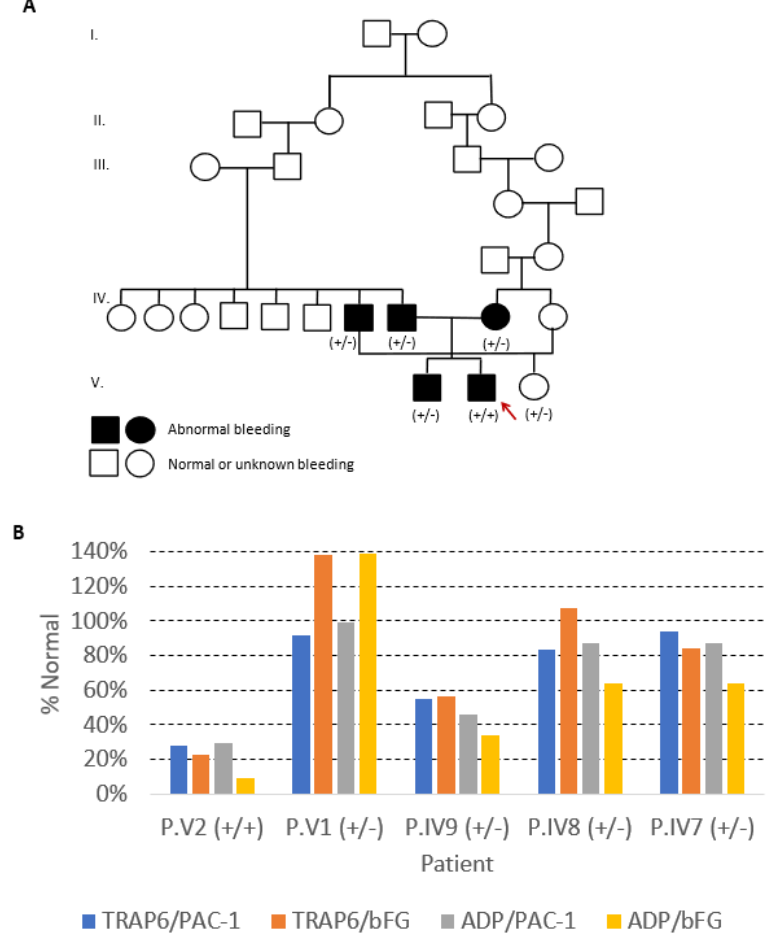
Figure 1. ( A ) Family pedigree of the index case (V2) with a homozygous likely pathogenic variant in RASGRP2 . The black symbols indicate cases with abnormal bleeding and the white symbols indicate family members without or unknown bleeding symptoms. The index case is signaled with an arrow. +/ − , heterozygous; +/+, homozygous for the variant. ( B ) Platelet α IIb β 3 integrin activation after stimulation with the agonists thrombin receptor-activating peptide-6 (TRAP6) and adenosine diphosphate (ADP), as evaluated by flow cytometry using fluorescein-conjugated PAC-1 and anti- bound fibrinogen (bFG) monoclonal antibodies (mAbs). The results are presented as percentages of the normal values, by dividing the median value of the fluorescence intensity of the patient’s platelets stained with PAC-1 and anti-bFG mAbs after stimulation with TRAP6 or with ADP by the median of correspondent values obtained in controls. Table 1. ISTH-BAT bleeding scores and laboratory results of the family